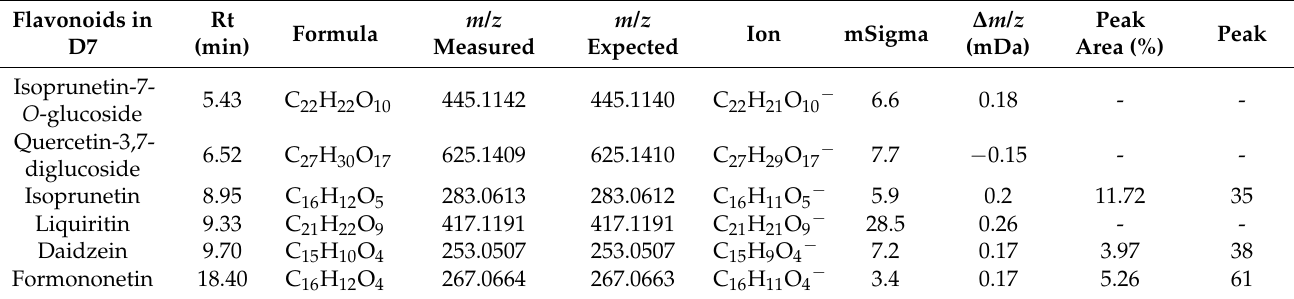
Table 3. Flavonoids identified in targeted analysis via UHPLC-ESI-QToF of sub-fraction D7 of U. gallii (Rt = retention time, m / z = mass/charge ratio of the compound, mSigma = deviation in the isotopic pattern, ∆ m / z = deviation in the mass ratio/charge measured in relation to the expected value).